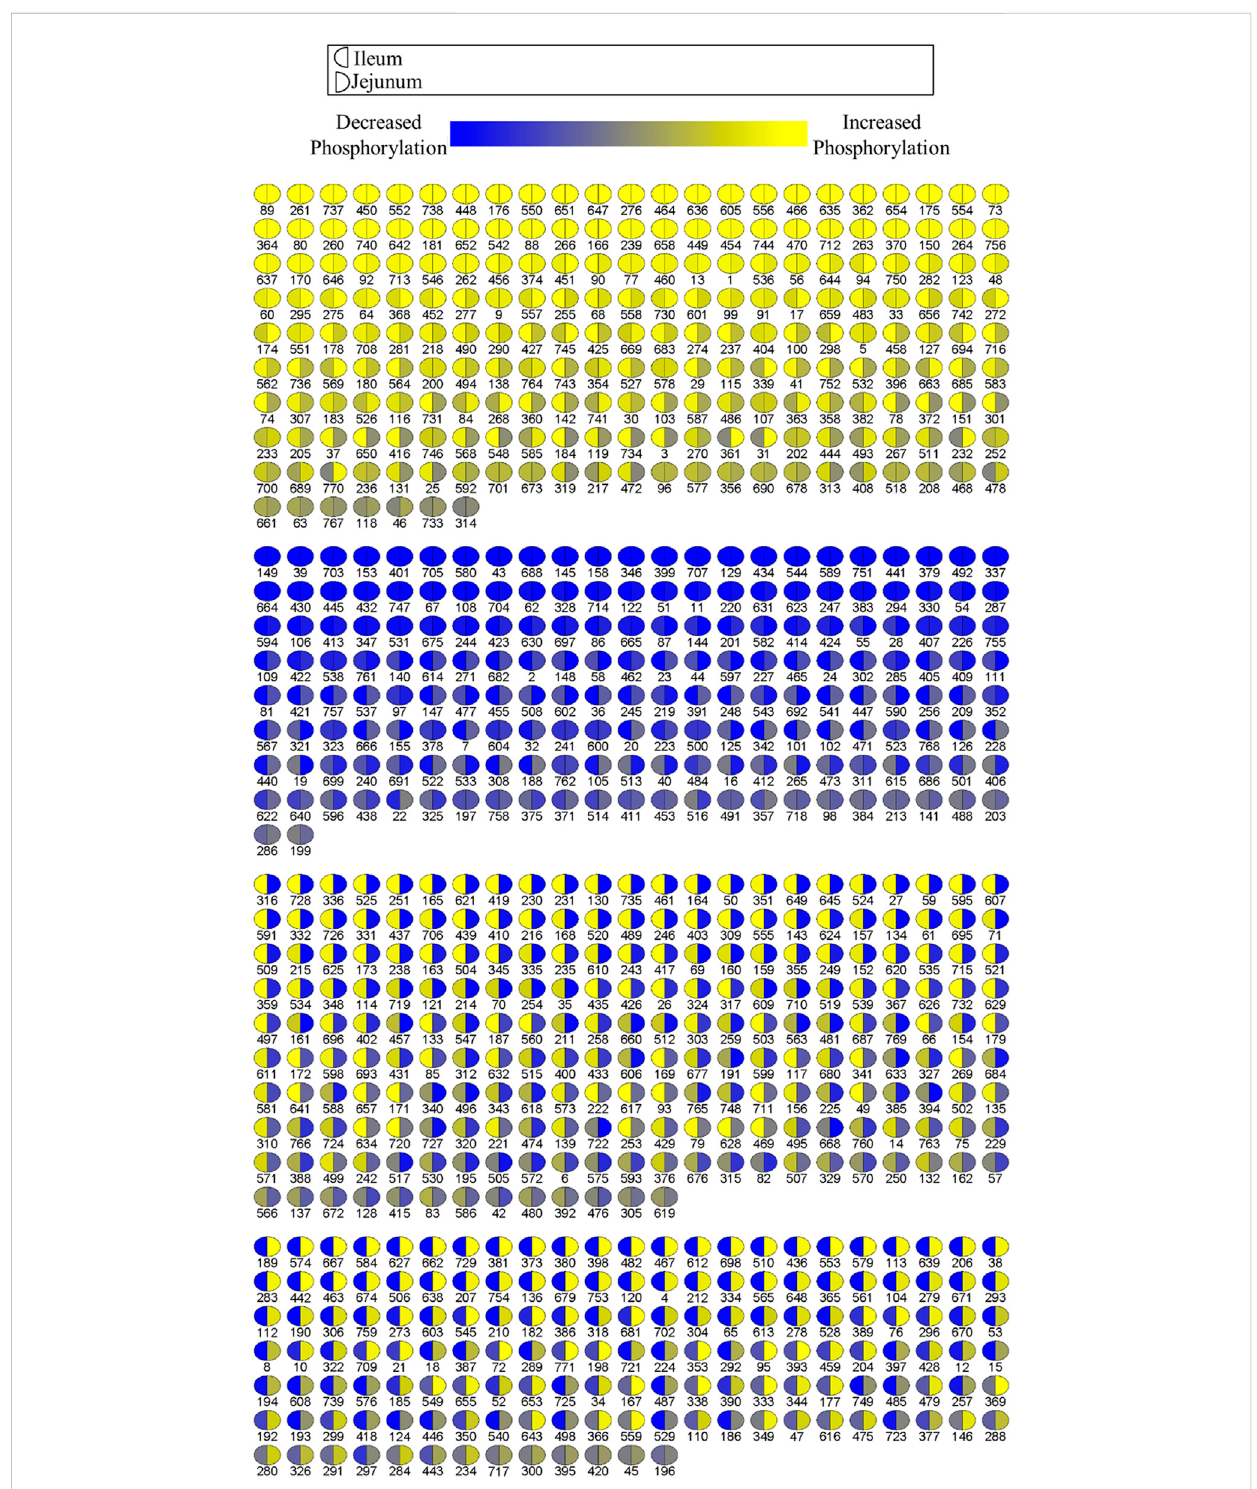
FIGURE 2 Comparison of relative phosphorylation of array peptides between ileum and jejunum due to product. Each spot represents a peptide on the array which corresponds to a kinase recognition site. The left half of each spot shows the differential phosphorylation status relative to control birds for ileum. The right side of each spot shows the phosphorylation status relative to control birds for